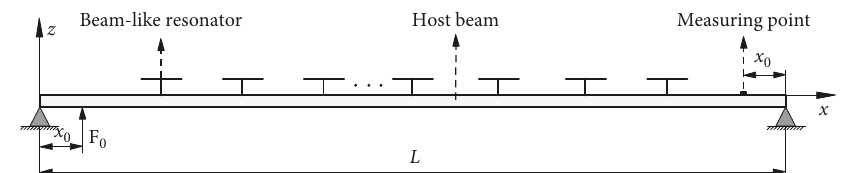
Figure 11: The analysis diagram concerns the vibration transmissibility of the finite locally resonant